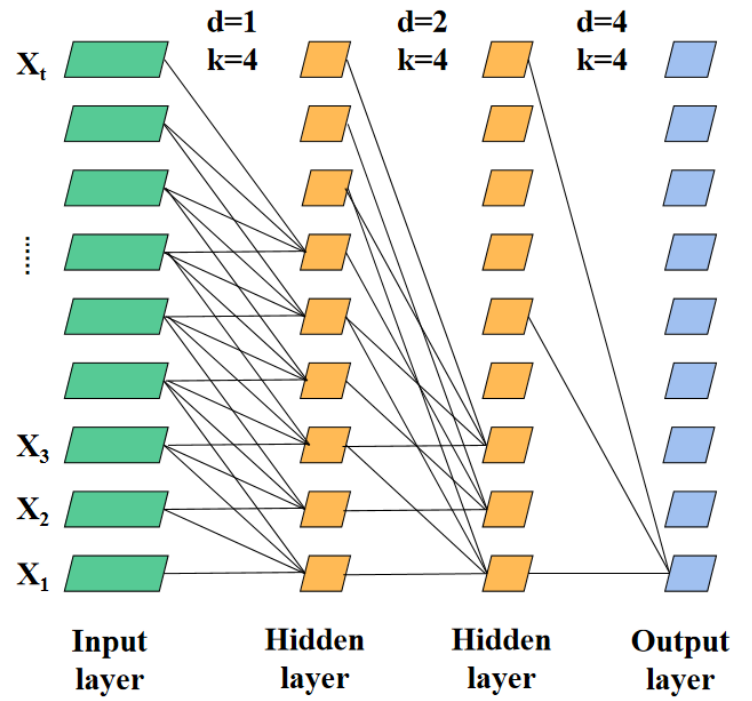
Figure 4. The architecture of stacked dilated convolution.